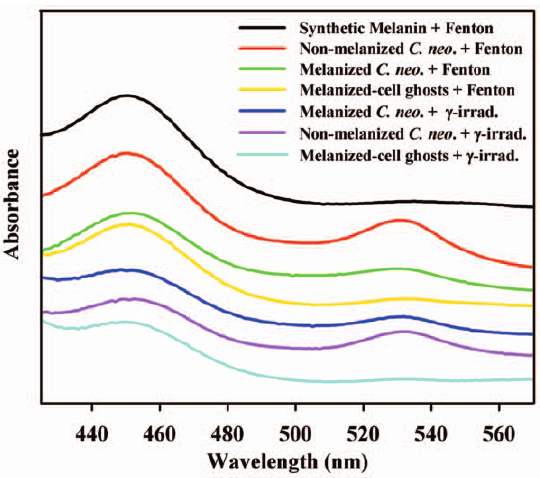
Figure 6. Optical spectra of TBA-adducts produced from supernatants collected from c -irradiated samples. Spectra are offset for presentation.